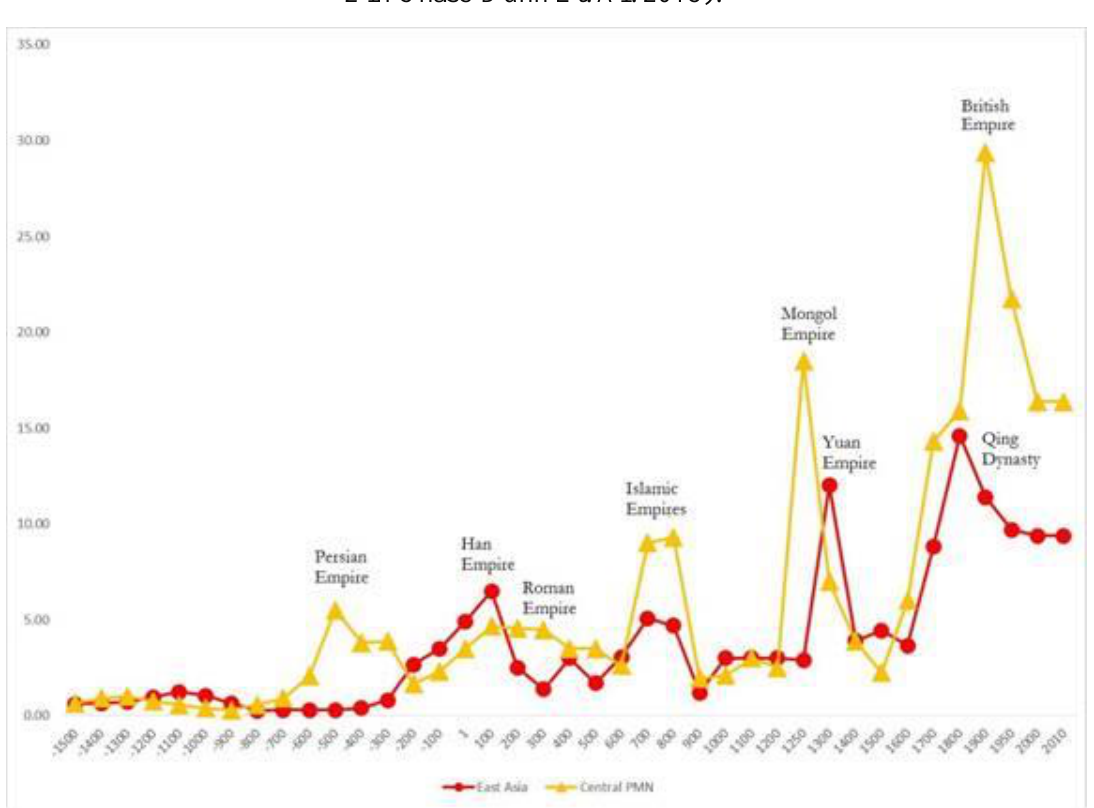
Figure 15. Eurasian Area Under State Control For 3.5 K Period 1.5k Bce—2.0k Ce (Figure 2 In Chase-Dunn Et. Al.